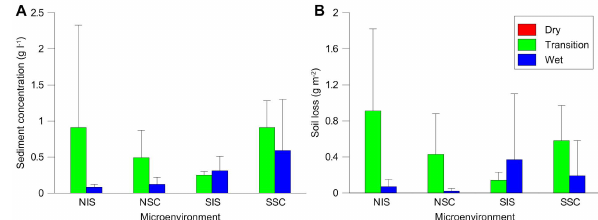
Fig. 7. Mean values of sediment concentration and soil loss in ev- ery microenvironment and season. Error bars represent standard deviation. NIS: north-facing inter-shrub; NSC: north-facing shrub- covered; SIS: south-facing inter-shrub; SSC: south-facing shrub- covered. No runoff was found in the dry